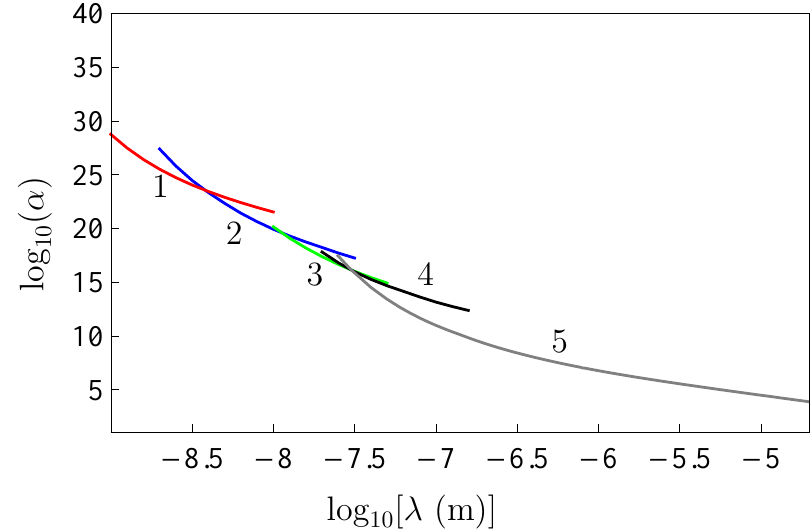
Figure 1. The strongest constraints on the Yukawa-type potentials obtained from measuring the Casimir force at nanometer separations (line 1), lateral Casimir force between corrugated surfaces (line 2), normal Casimir force between corrugated surfaces (line 3), the Casimir pressure (line 4), and from the Casimir-less experiment (line 5). The plane areas above the lines are excluded and below them are allowed by the measurement data.